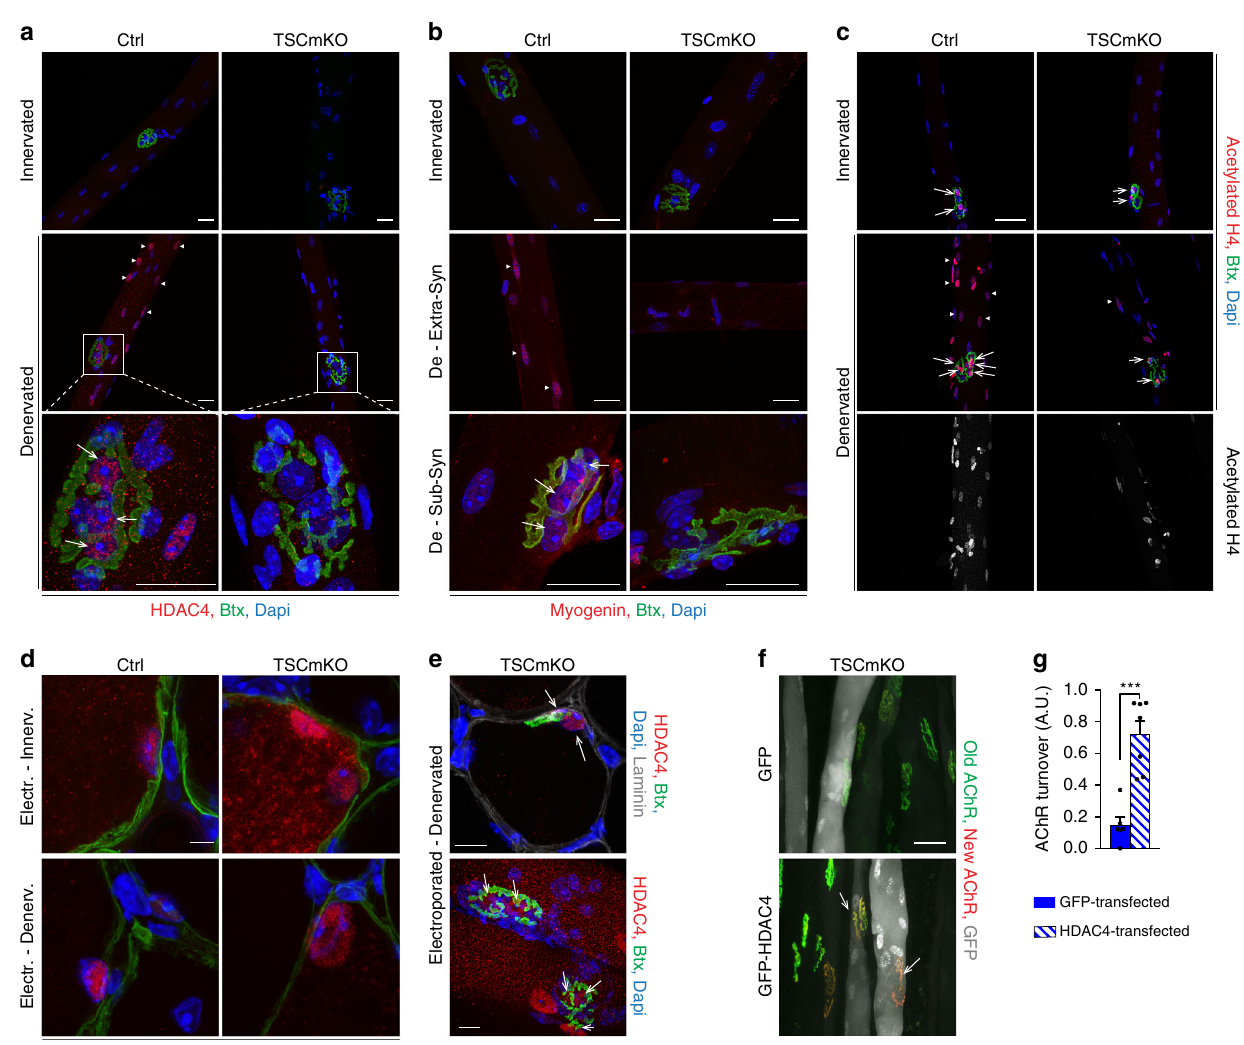
Fig. 7 Impaired nuclear import of HDAC4 contributes to endplate defect in TSCmKO muscle. a – c Confocal pictures of HDAC4 (red, a ), myogenin (red, b ) and acetylated histone H4 (red, c ) combined with α -bungarotoxin (Btx, green) in single fi bers isolated from innervated and denervated (De) control (Ctrl) and TSCmKO muscles. Arrows and arrowheads show sub- and extra-synaptic (Syn) myonuclei, respectively. Representative of 4 independent muscles. Scale bar, 25 µ m. d Confocal pictures of electroporated HDAC4 (red) and laminin (green) in innervated and denervated control and TSCmKO muscles. Representative of 4 independent muscles. Scale bar, 5 µ m. 3D reconstruction is given in Supplementary Fig. 7d. e Confocal pictures of electroporated HDAC4 (red), α -bungarotoxin (Btx, green) and laminin (gray) on muscle section (upper panel) or in isolated fi bers (bottom panel) from TSCmKO denervated muscle. Arrows point to sub-synaptic nuclei. Representative of 4 independent muscles. Scale bar, 10 µ m. f , g Representative confocal pictures of “ old ” (green) and “ new ” (red) AChRs in TSCmKO denervated muscles (14d), electroporated with GFP or GFP-HDAC4 (gray). Scale bar, 50 µ m. Turnover quanti fi cation is given in ( g ); values are mean ± s.e.m.; n = 6 GFP and 7 HDAC4 independent assays (number of mice electroporated; 136 and 50 fi bers quanti fi ed, respectively); two-tailed unpaired Student ’ s t- test, *** p < 0.001. Source Data are provided in the Source Data